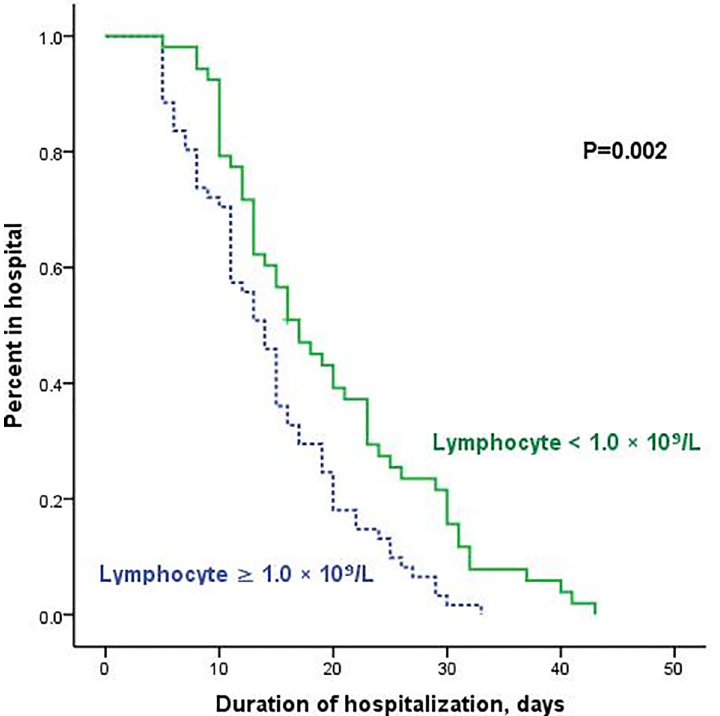
Fig 4. Kaplan-Meier curves for the duration of hospitalization according to lymphocyte count.